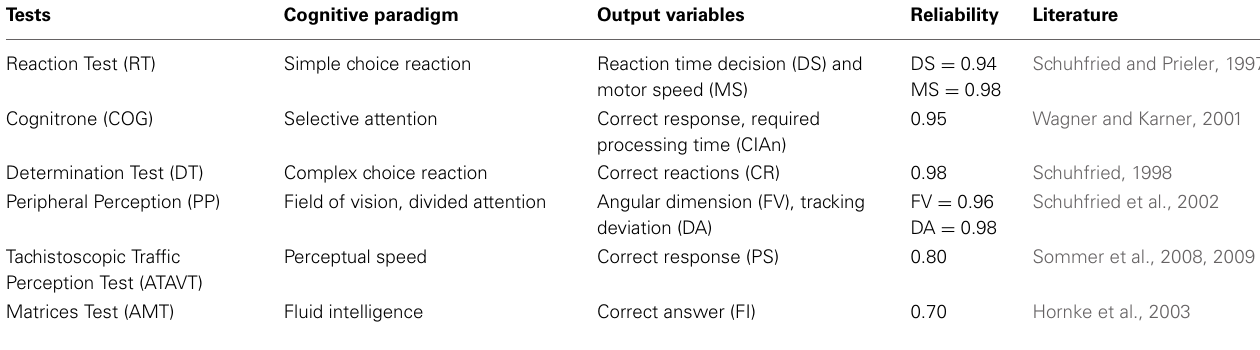
Table 3 | Expert System Traffic XPSV